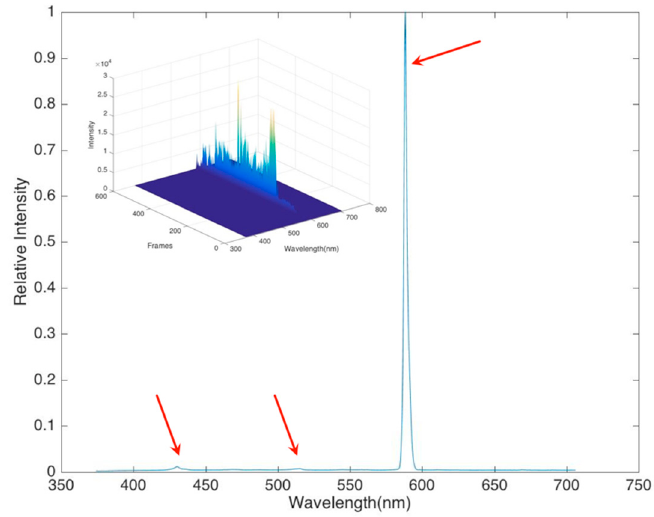
Figure 8. Gas hydrate spectrum over visible range; three peaks were found.